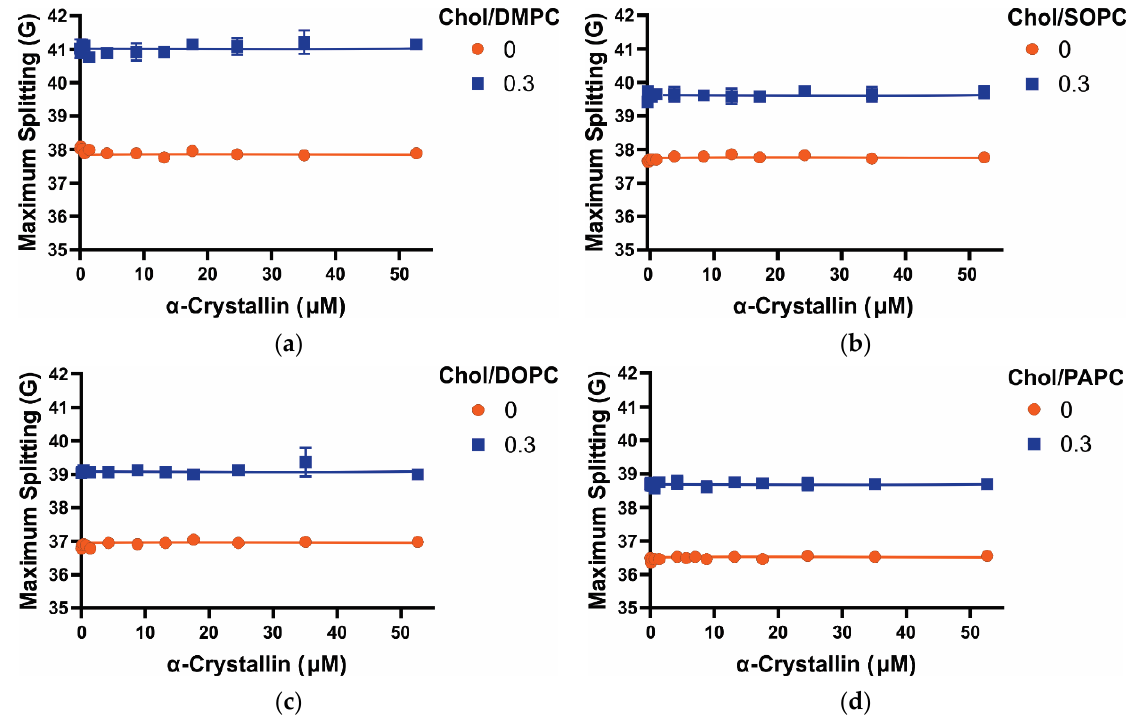
Figure 5. ( a – d ) Show the profiles of the maximum splitting plotted as a function of α -crystallin concentration for Chol/DMPC, Chol/SOPC, Chol/DOPC, and Chol/PAPC membranes, respectively, at Chol and PL mixing ratios of 0 and 0.3. Our previous studies [45–47] explain a detailed method to calculate the maximum splitting. The data points are expressed as mean ± standard deviation from three independent experiments, and the solid lines serve as the visual guides. The maximum splitting values are different for different PC membranes, indicating that the order of the membranes near the headgroup regions depends on the acyl chain length and degree of unsaturation of membranes. The trends of the maximum splitting are the same as the trends of the K a (see Figure 3), showing the direct correlation between maximum splitting and the K a . For all the Chol-free and Chol-containing PC membranes, the maximum splitting does not significantly change with an increase in α -crystallin concentration, representing that the order near the headgroup regions of these membranes does not significantly change with or without α -crystallin association. The addition of Chol increases the maximum splitting of membranes, representing that these membranes become more ordered near the headgroup regions with increased Chol content.